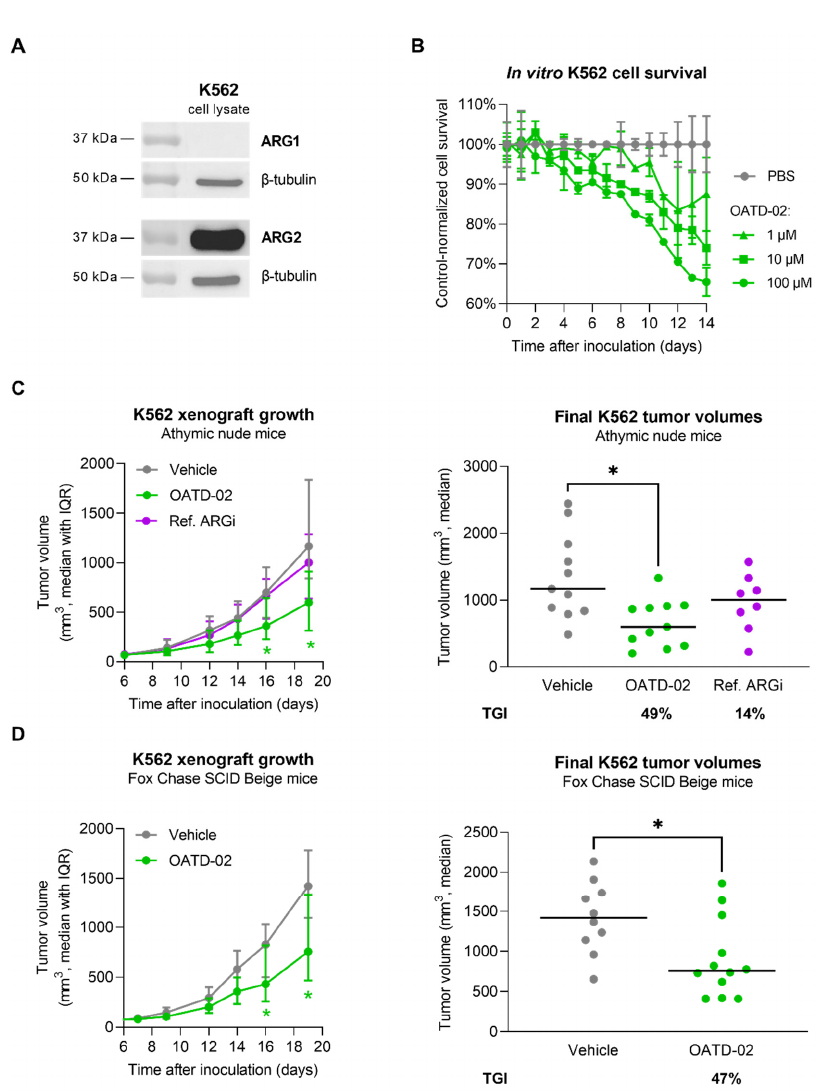
Figure 5. OATD-02 shows significant therapeutic efficacy in the human CML model using K562 cells. ( A )—ARG1 and ARG2 expression was assessed in K562 cell lysates by SDS-PAGE/WB with specific antibodies; ( B )—OATD-02 exhibited dose-dependent effect on the cell survival in a long-term K562 cell culture; ( C )—Athymic nude mice were inoculated with K562 cells and test compound administration started when the xenografts became palpable (day 6); OATD-02 was dosed at 50 mg/kg (PO, BID) and Ref. ARGi was dosed at 100 mg/kg (PO, BID) until the end of the experiment; final tumour measurements were taken at day 19 post-inoculation and TGI was calculated (* 0.0172 < p < 0.0428, Kruskal–Wallis test with Dunn’s multiple comparisons test); ( D )—T and NK cell-deficient mice (strain Fox Chase SCID Beige) were inoculated with K562 cells and OATD-02 was dosed at 50 mg/kg (PO, BID) from day 7 until the end of the experiment; final tumour volumes (day 19) were used for TGI calculations (* 0.0201 < p < 0.0449, U Mann–Whitney